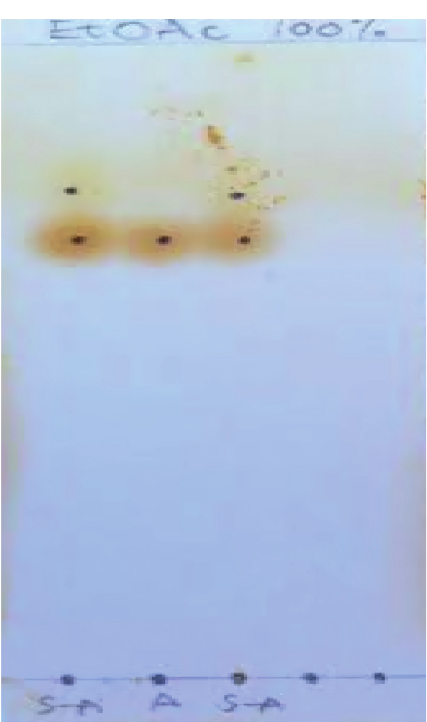
Figure 5: Thin layer chromatography